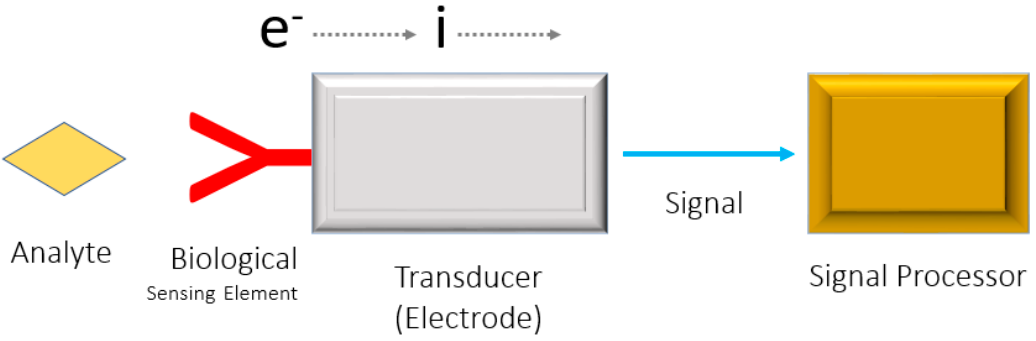
Figure 1. Schematic illustration of mechanism/principle of electrochemical biosensor.